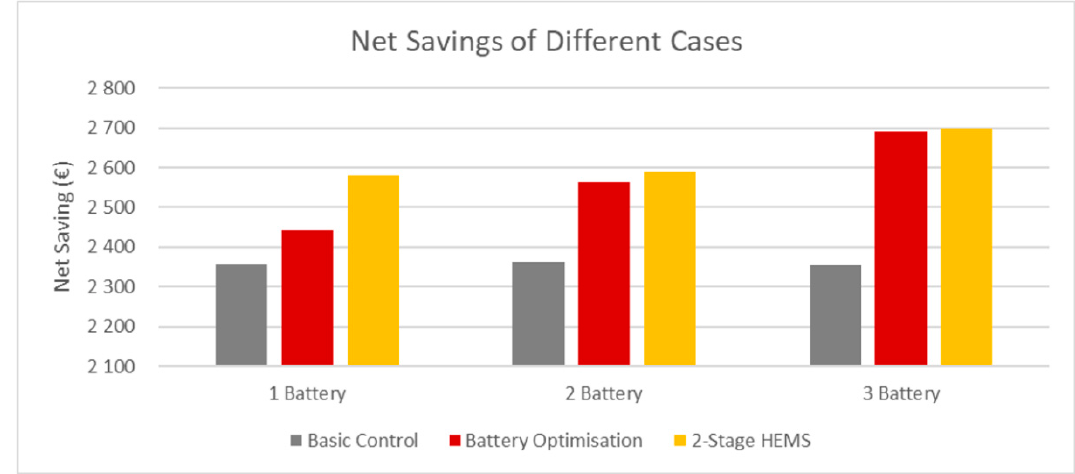
Figure 20. Annual net saving of different cases.